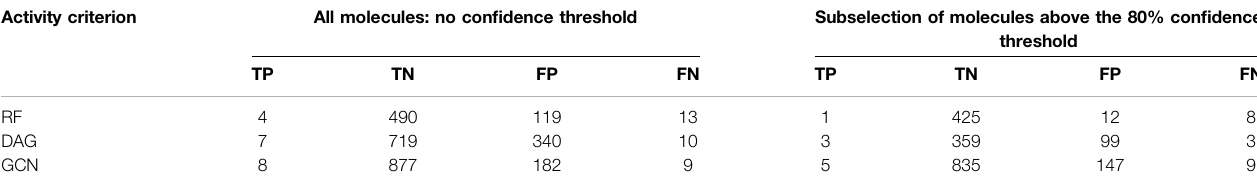
TABLE 3 | External validation of the three models ’ performances in comparison with experimental results from the PubChem bioassay AID_1409594. Columns 2 – 5 report TP,TN,FP,andFNcountsbasedontheoverallpredictionsofthealgorithms.Columns6 – 9reporttheTP,TN,FP,andFNcountsbasedonthesubselectionofmolecules with prediction con fi dence higher than